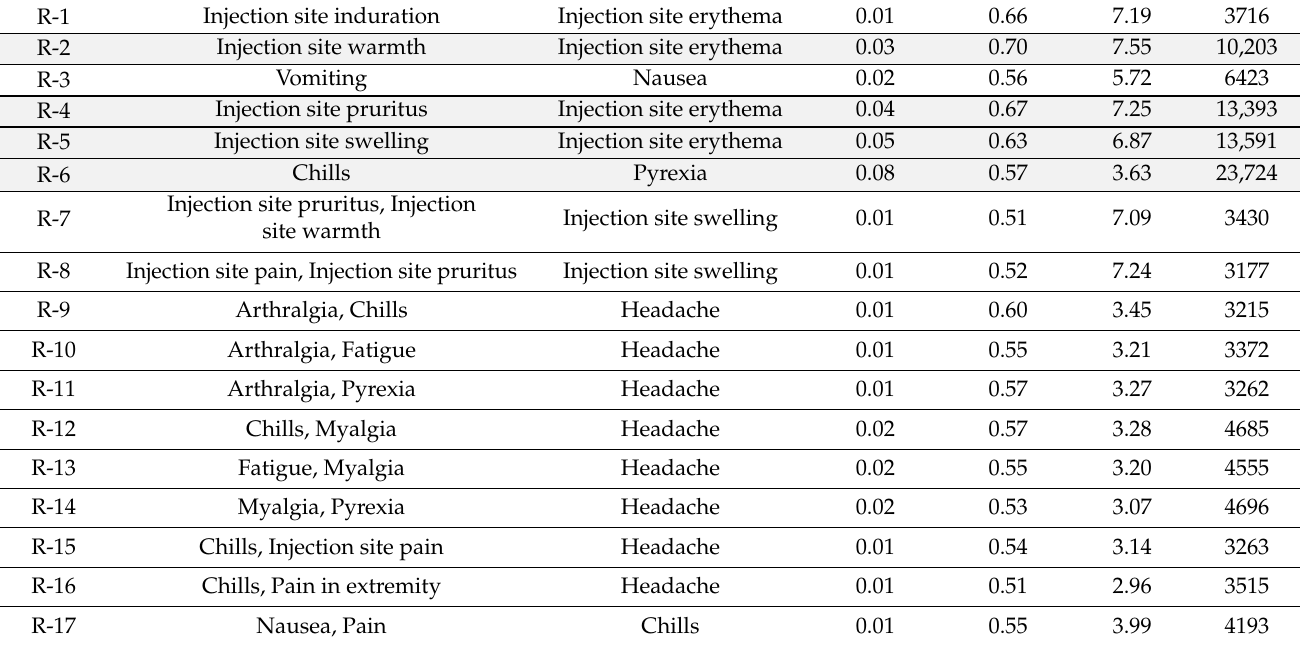
Table 4. Non-redundant association rules for AEs reported in VAERS reports for the three